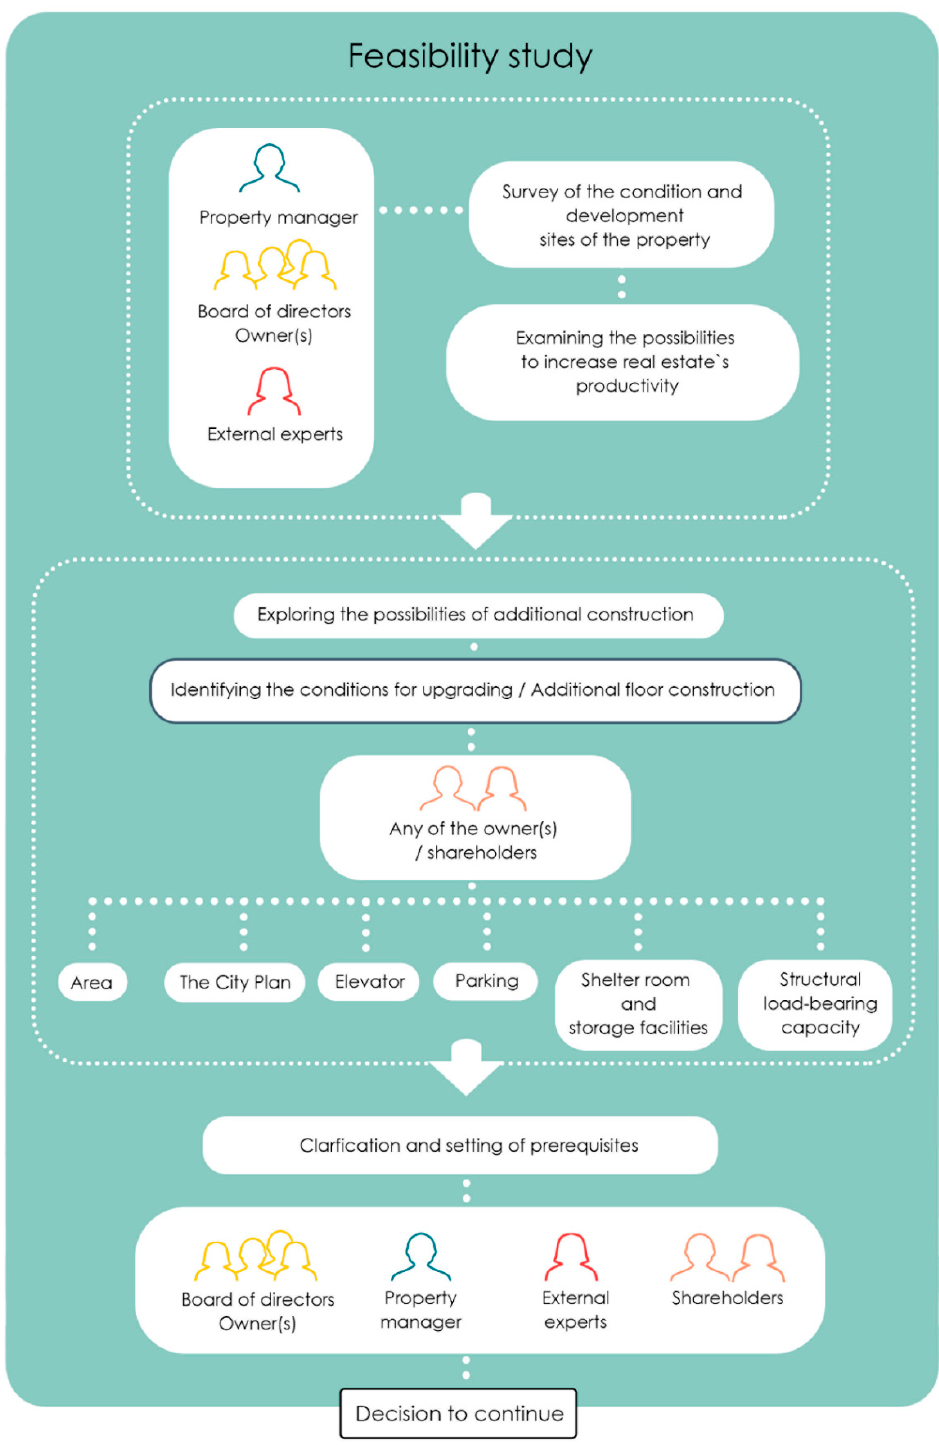
Figure 3. Feasibility study of additional floors.